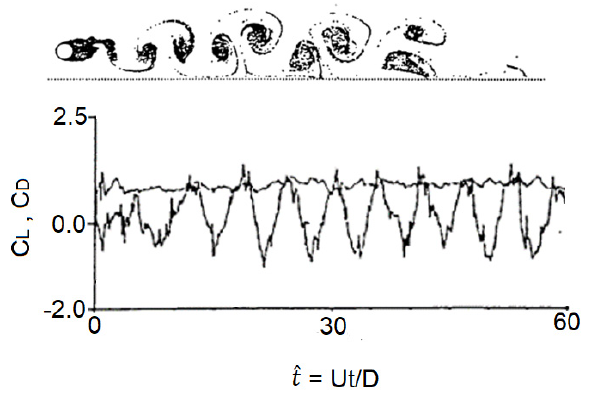
Figure 7. The flow pattern and force coefficients for G/D = 1.5 and Re = 100,000.